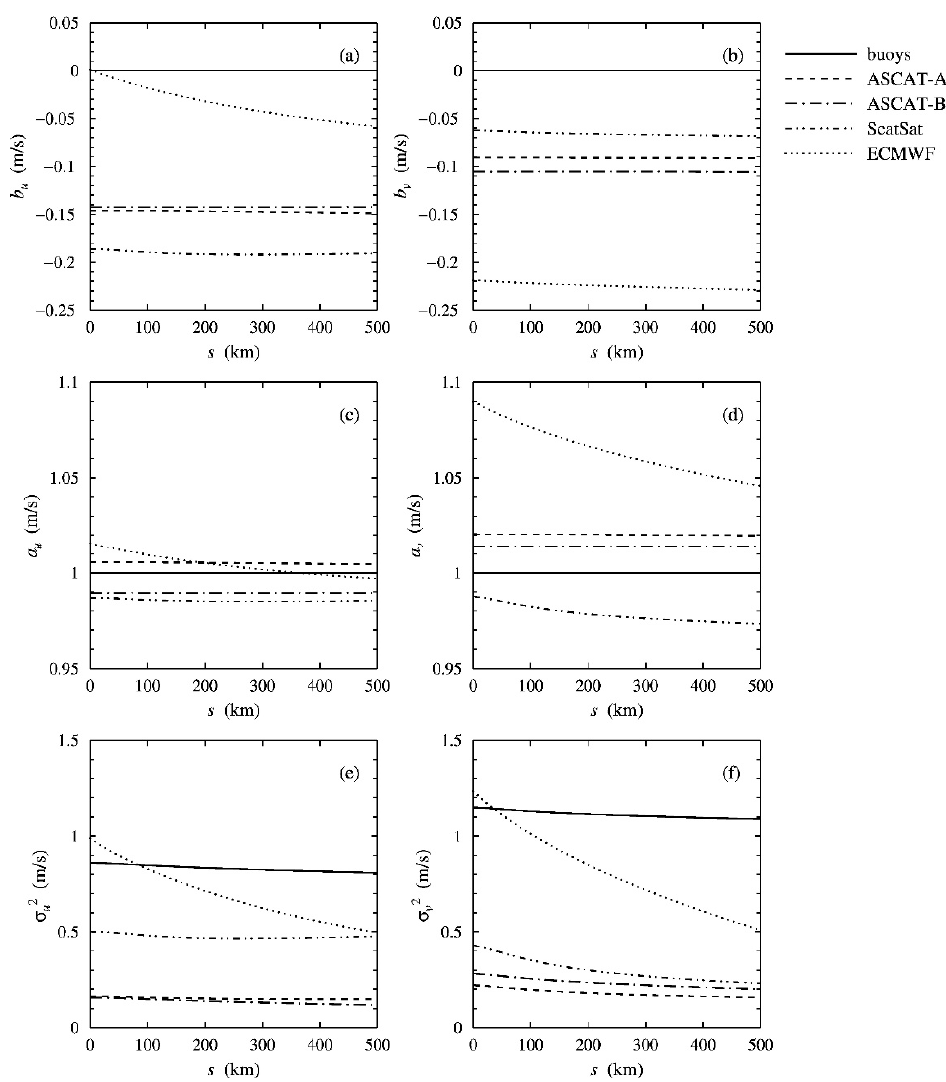
Figure 2. Quintuple collocation results as a function of the scale at which the representativeness errors are calculated for the calibration biases for u ( a ), the calibration biases for v ( b ), the calibration scalings for u ( c ), the calibration scalings for v ( d ), the error variances for u ( e ), and the error variances for v ( f ), all averaged over all